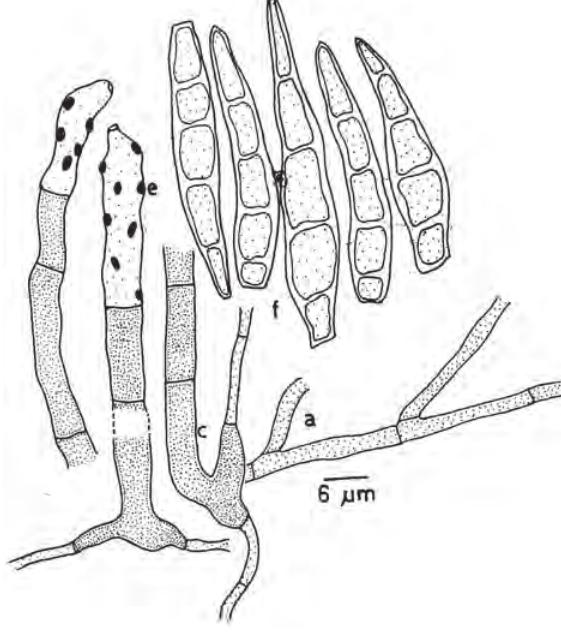
Figure 201. Spiropes capensis a - Septate mycelium; c - Conidiophores; e - Conidiogenous cells; f - Conidia